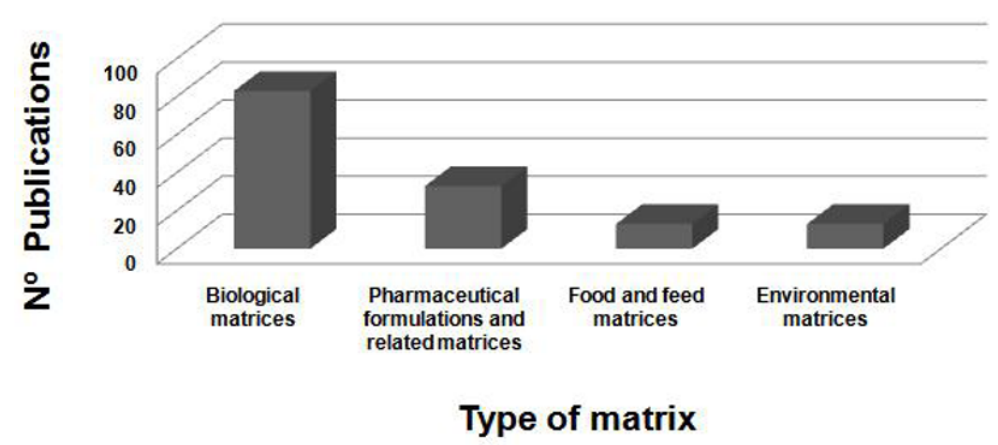
Figure 1. HILIC pharmaceutical analysis published research for the last six years (to end of May 2011) listed in ISI-Web of Knowledge, Scirus, and Scopus using keywords: [(Hydrophilic Interaction Chromatography) or (HILIC)] and [(Drugs) or (Pharmaceuticals) or (Drugs of abuse)]